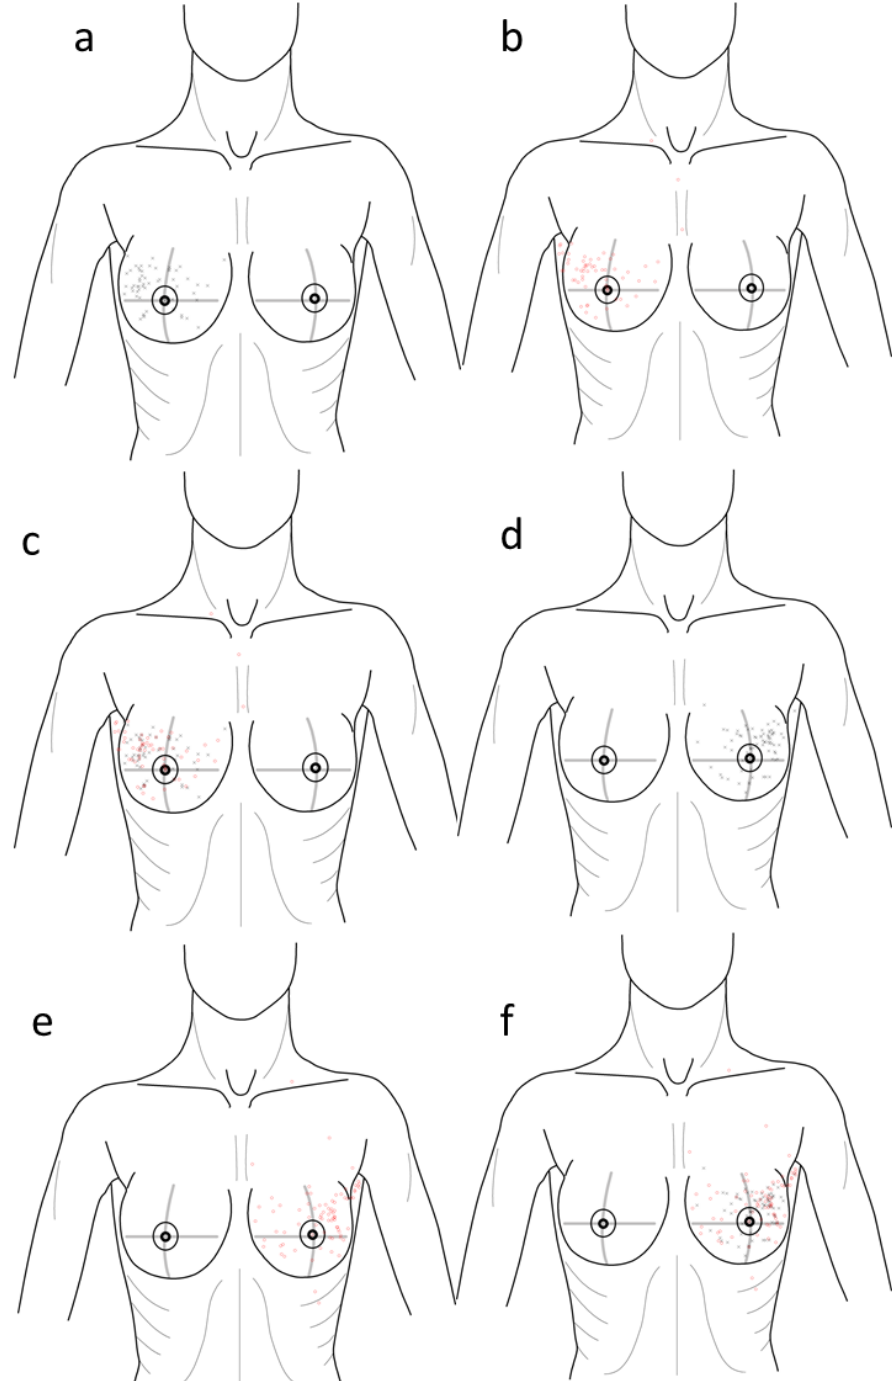
Figure 1. Distribution of ( a ) right primary breast cancer cases ( b ) site of recurrences and ( c ) both, ( d – f ) cases on the left side.